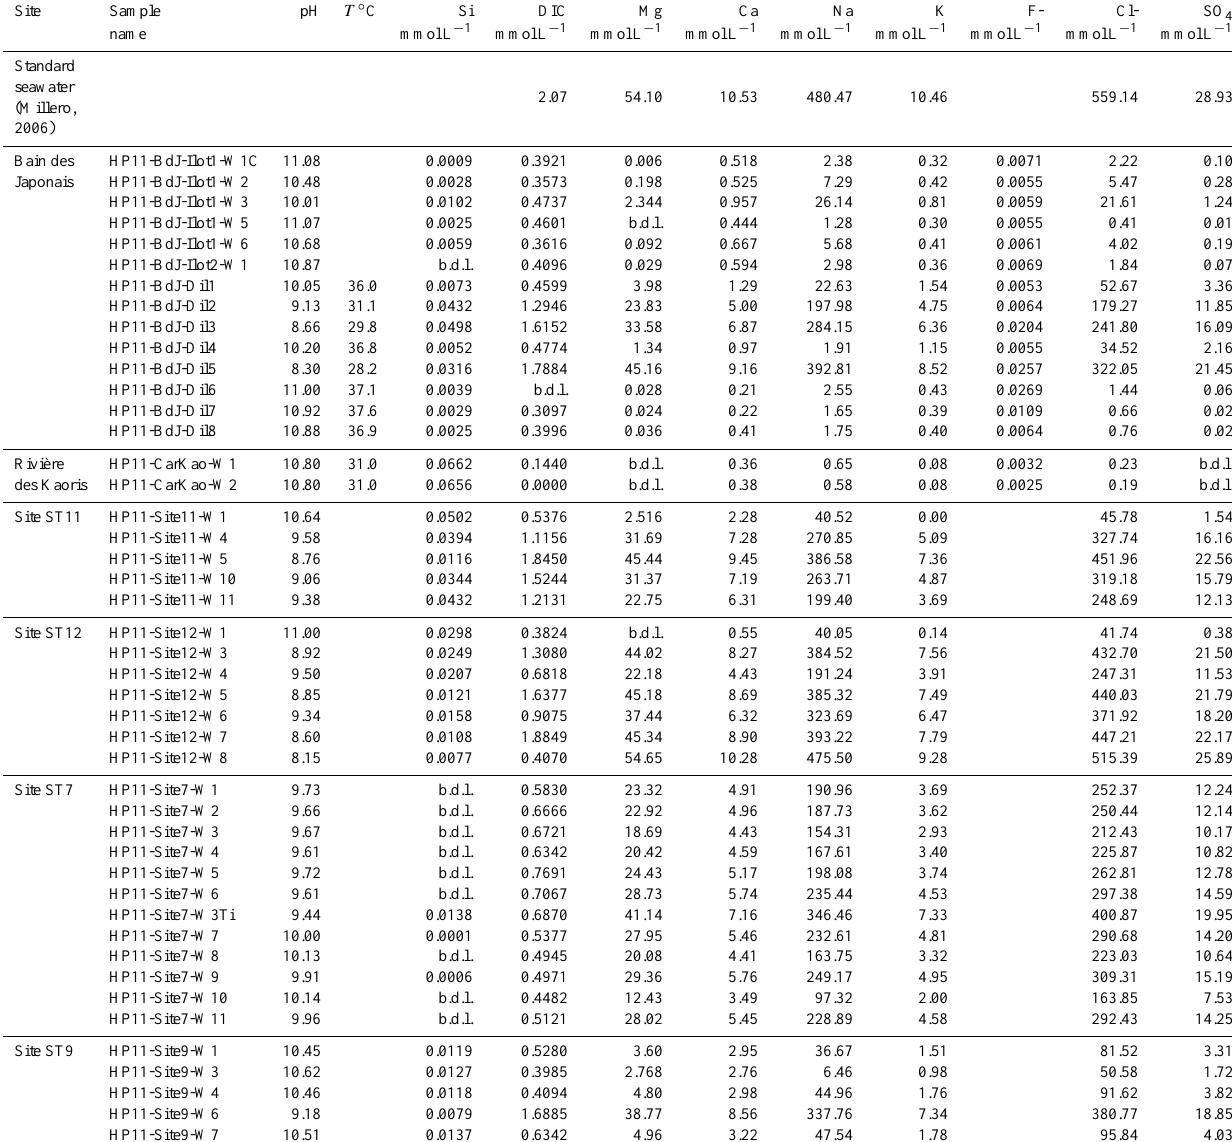
Table 2. Major and minor elemental composition and temperature of the waters collected in Prony Bay during the HYDROPRONY cruise (b.d.l.: below detection level; DIC: dissolved inorganic carbon).